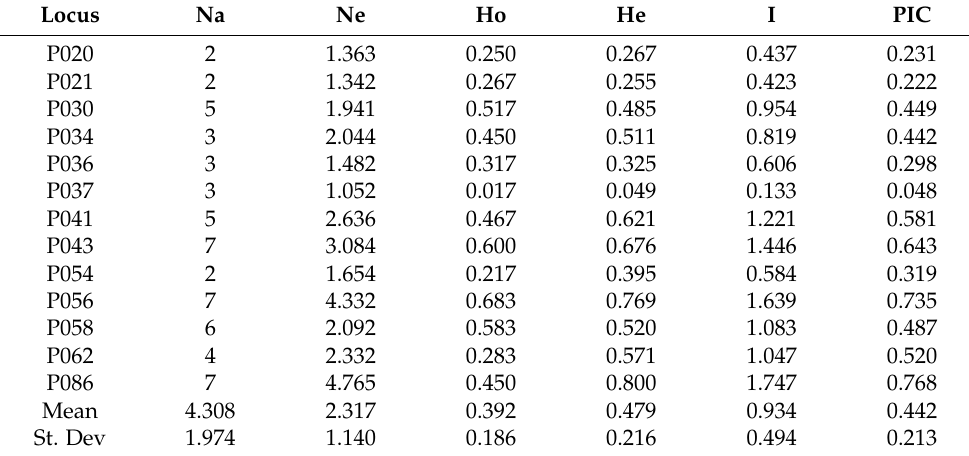
Table 5. Characteristics of 13 polymorphic SSR sites in H. molitrix .